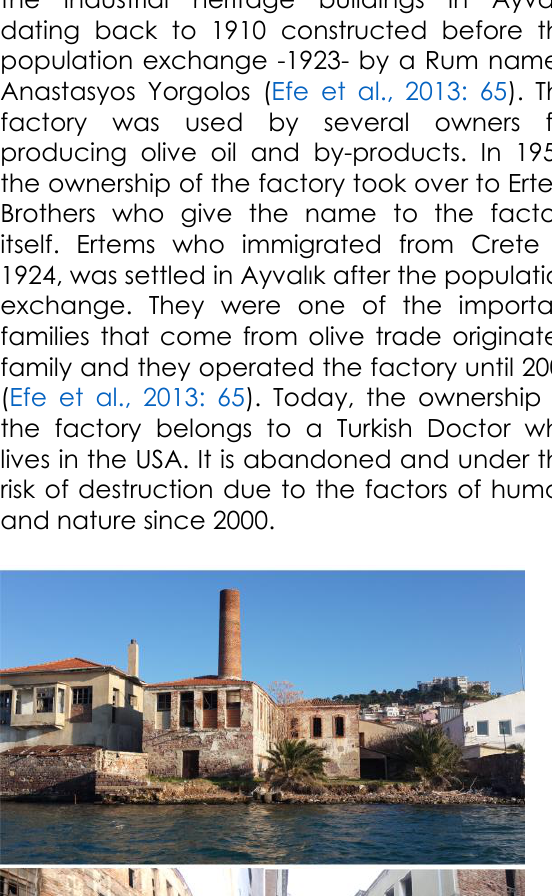
Street, from the middle block named as